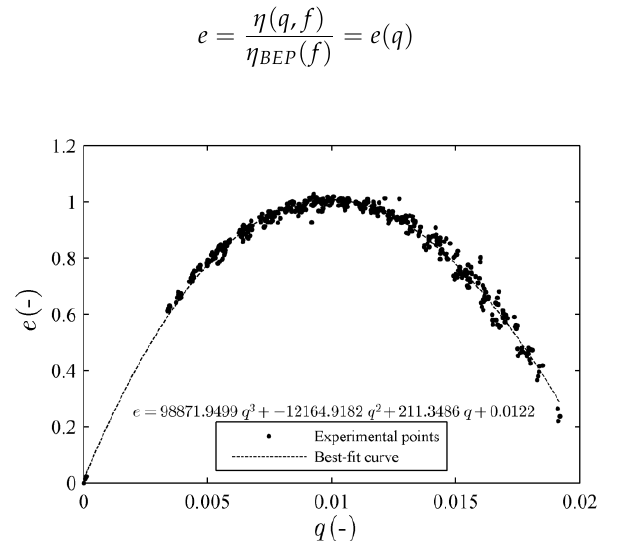
Figure 8. Experimental measurements of e against the dimensionless discharge e ( q ) and best-fit